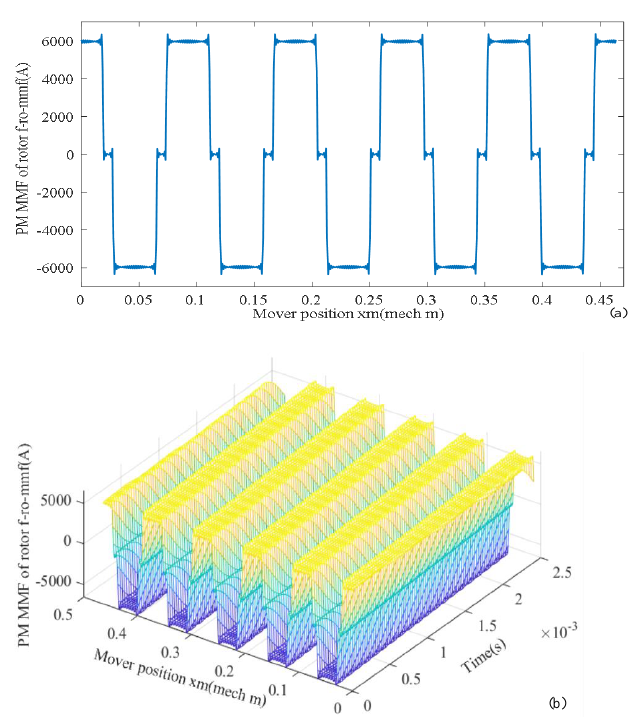
Figure 17. PM MMF ( a ) changing with space x m , ( b ) changing with time t and space x m.